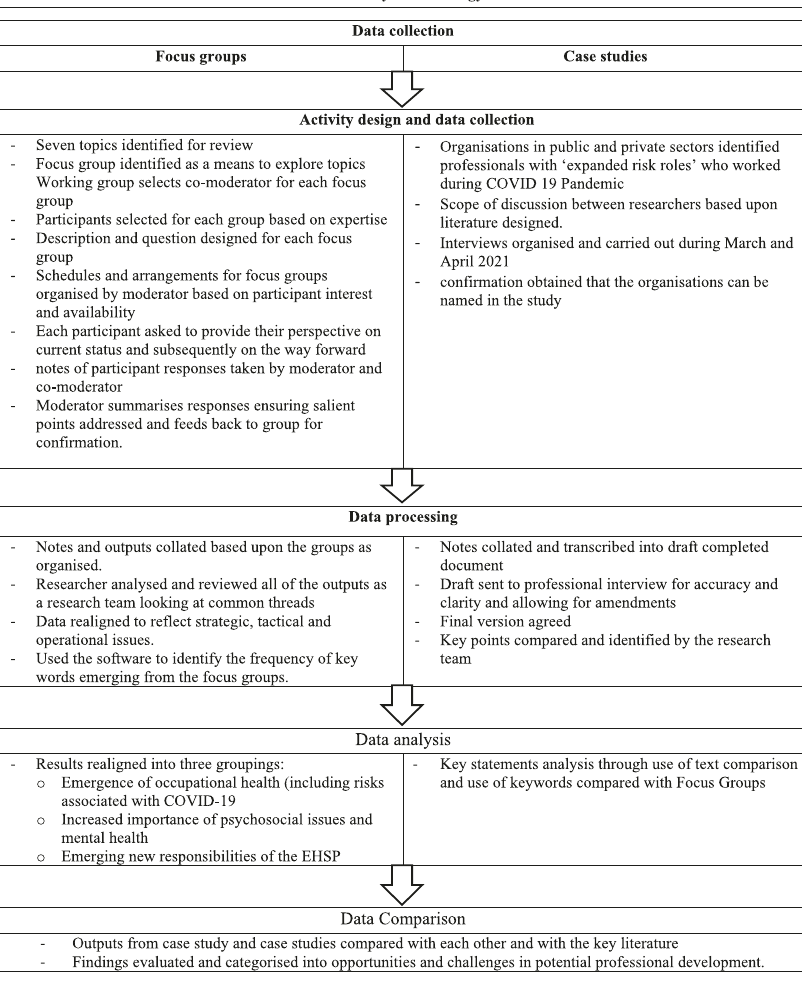
Fig. 1 A summary of the research methodology. This summary includes methods used to generate, compare and analyse the data generated by the